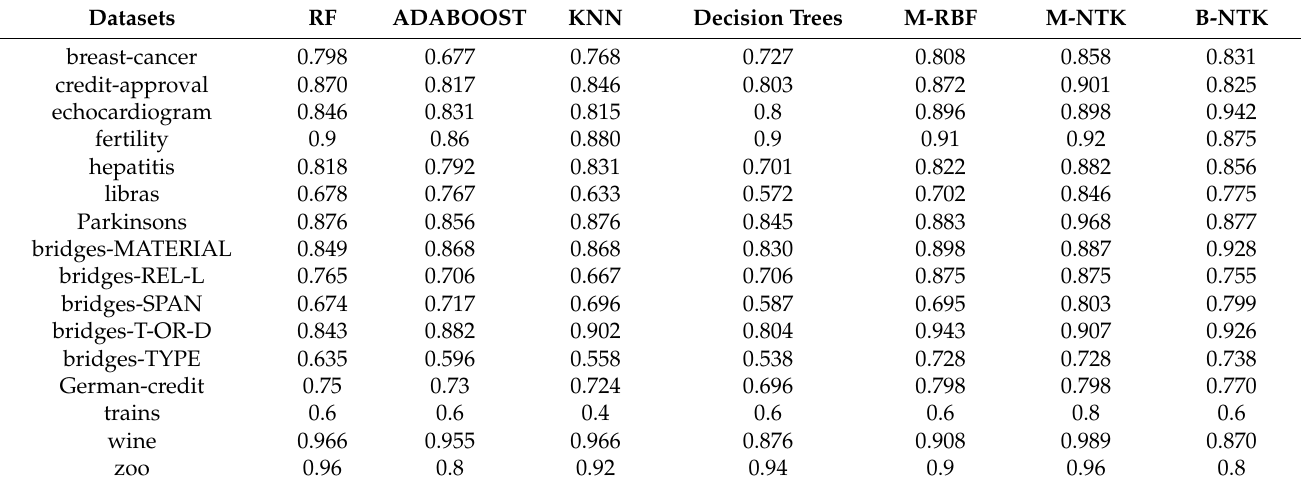
Table 4. Acc-Comparison between our model and commonly used standard models.